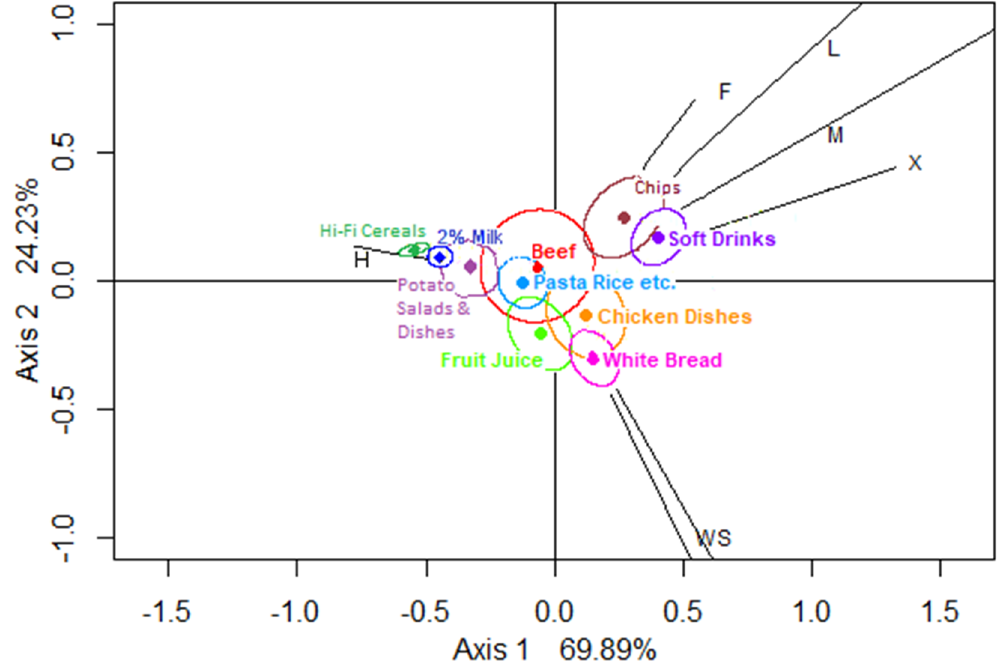
Figure 2. Biplot of locations showing confidence regions for neutral food groups